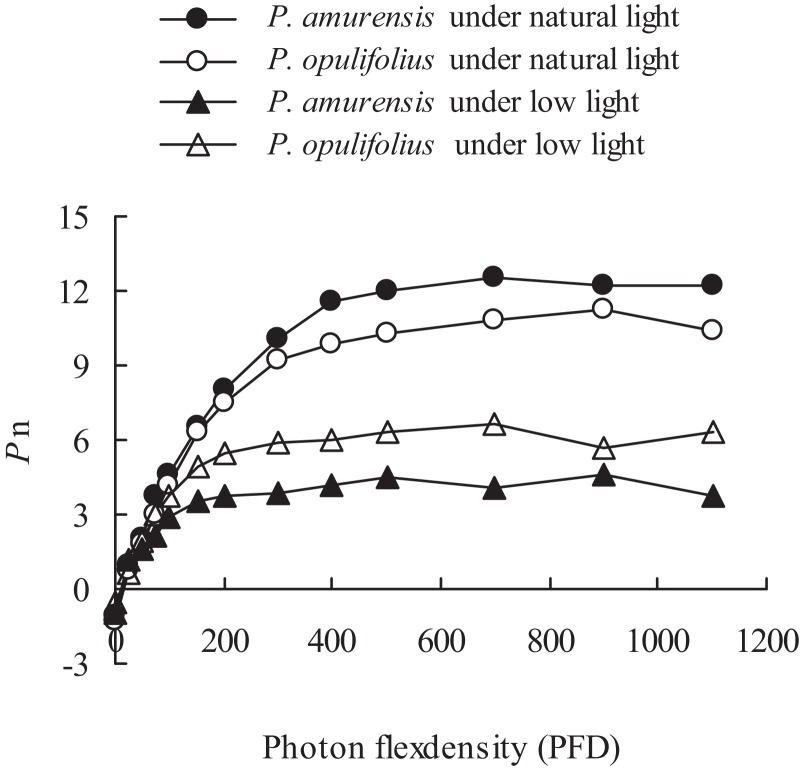
Net photosynthesis rate in response to illumination intensity in leaves of P. amurensis Maxim and P. opulifolius “Diabolo” under different light intensities.Black squares denote.., white squares denote P. opulifolius under natural light conditions, and white triangles denote P. opulifolius under low light conditions. Error bars depict X.